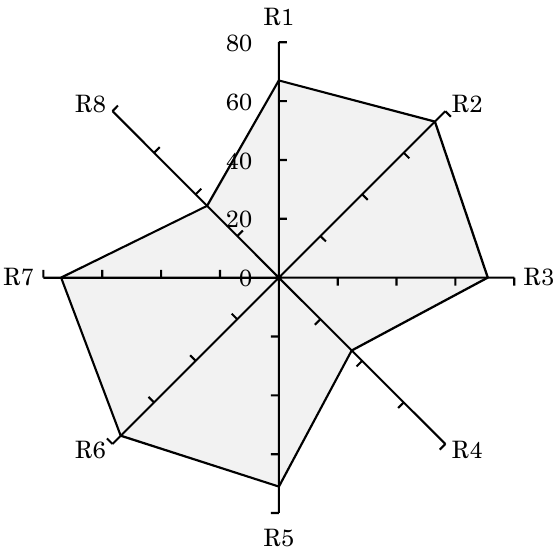
mainly high R values including two downward outliers - Rmean=62,9; CV=26,2%; Fu=63,2kN (granulite - chemical anchor - undisturbed) Figure 12. High rebound values including two downward outliers (CV, Rmean, F u ). In Figure 13, a lower threshold value for the rebound values was defined. In order to determine the threshold value, a log normal distribution was assumed for all undisturbed rebound values. Calculating the 5% fractile from this distribution, a mean rebound value of 53.2, a standard deviation of 1.3, and a k-value of 1.645 for an infinite sample size were used. Conclusively, a threshold of 36 resulted. When highlighting all anchors in undisturbed areas for which none of the eight rebound values is below this threshold, good rebound values and failure loads can be obtained.